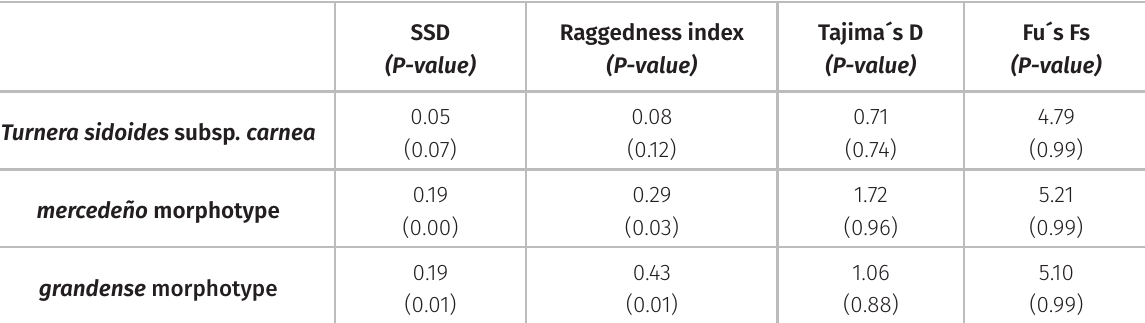
Table VI. Results of the mismatch distribution analysis and neutrality tests of T. sidoides subsp. carnea and their morphotypes, obtained from intergenic cpDNA